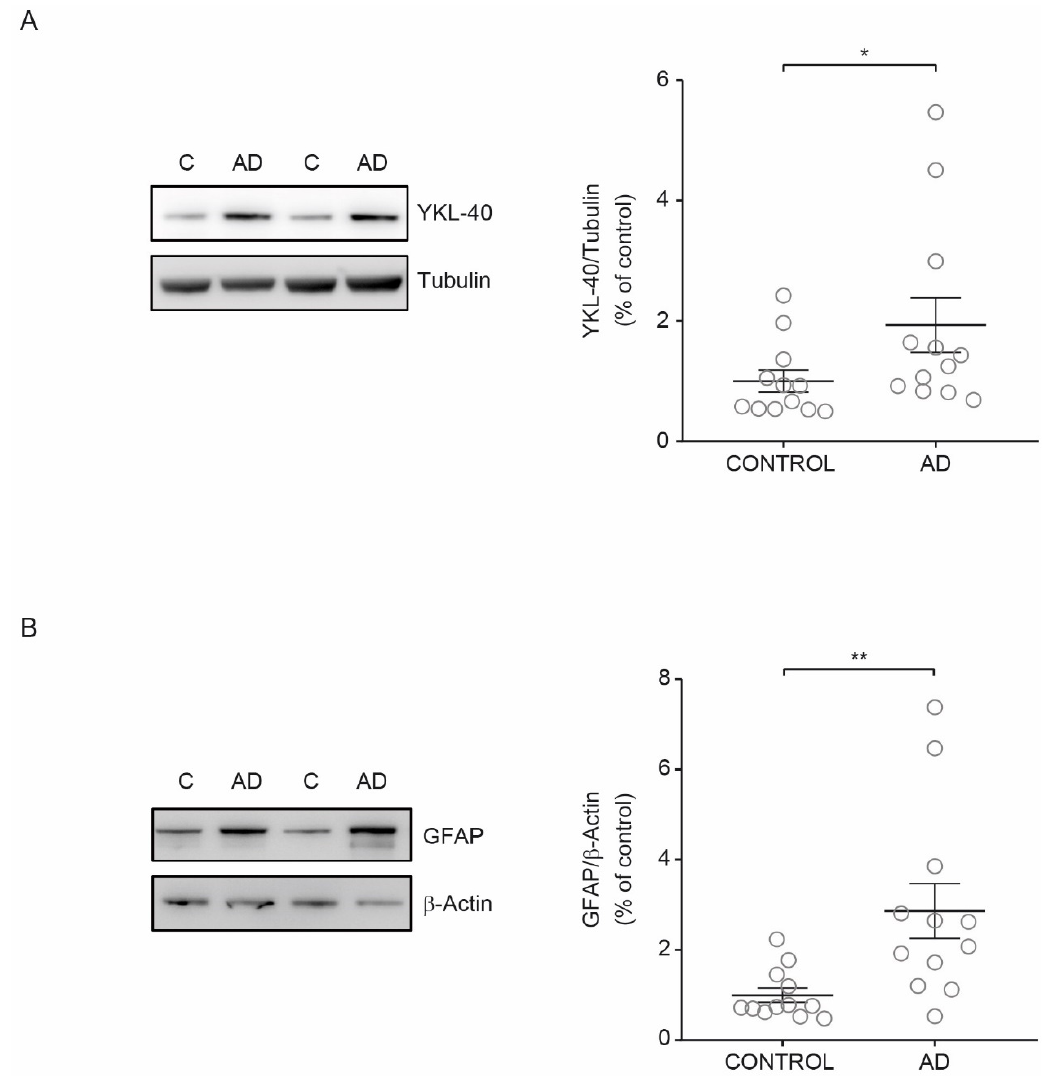
Figure 4. YKL-40 and GFAP levels in cerebral orbitofrontal cortex of AD patients and control group. Western blot analysis showing ( A ) YKL-40 and ( B ) GFAP in the cerebral orbitofrontal cortex of AD and control samples. Representative Western blots (left panels) and histograms with their densitometric analysis (right panels) are shown. Data are represented as the mean ± SEM. Differences between groups were assessed using Mann–Whitney test; * p < 0.05, ** p < 0.01.